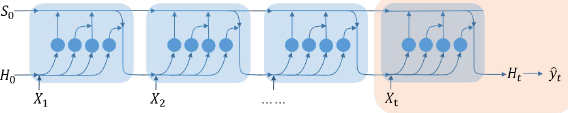
Figure 4. The illustration of ConvLSTM for time series data. For traditional ConvLSTM, the loss function is defined as the standard cross-entropy which is calculate by the predicted label and respective reference label from ground truth data during the training process. This is essentially a supervised classification that needs large enough labels for training. Actually for the classification task of long time series remote sensing data, corresponding labels are mixtures with labelled D iL and un- labelled data D iU , rather than labels for every image. Thus, semi-supervised learning inspired by Π-model (Laine and Aila, 2018) is utilized. Figure 5 illustrates the procedure of semi- supervised learning and the calculation of loss function shown in (3), consists of supervised and unsupervised loss . As components. One is the standard cross-entropy between models’  predictions ŷ i and reference labels D iL , evaluated for labels only. Because of the class imbalance, inspired by the Focal Loss (Lin et al., 2020), the tunable focusing parameter γ is adopted to add a modulating factor (1- ŷ i * D iL ) γ to the cross entropy loss.